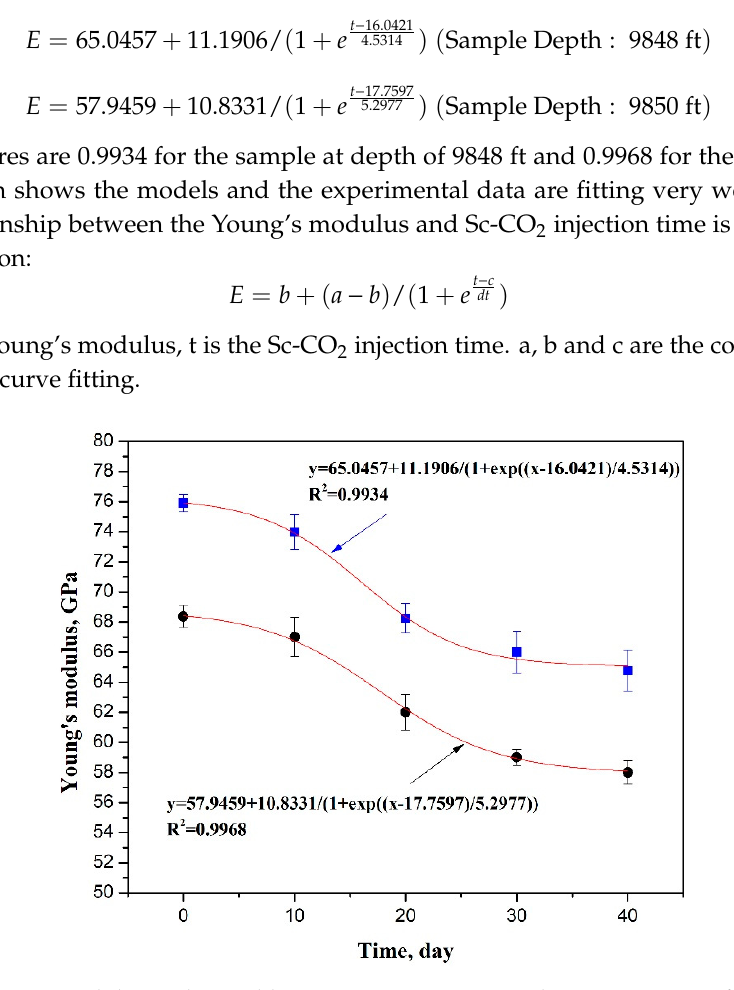
Figure 4. Young’s modulus with variable Sc-CO 2 injection time. The upper curve is for the sample with depth at 9848 ft, the lower curve is for the sample with depth at 9850